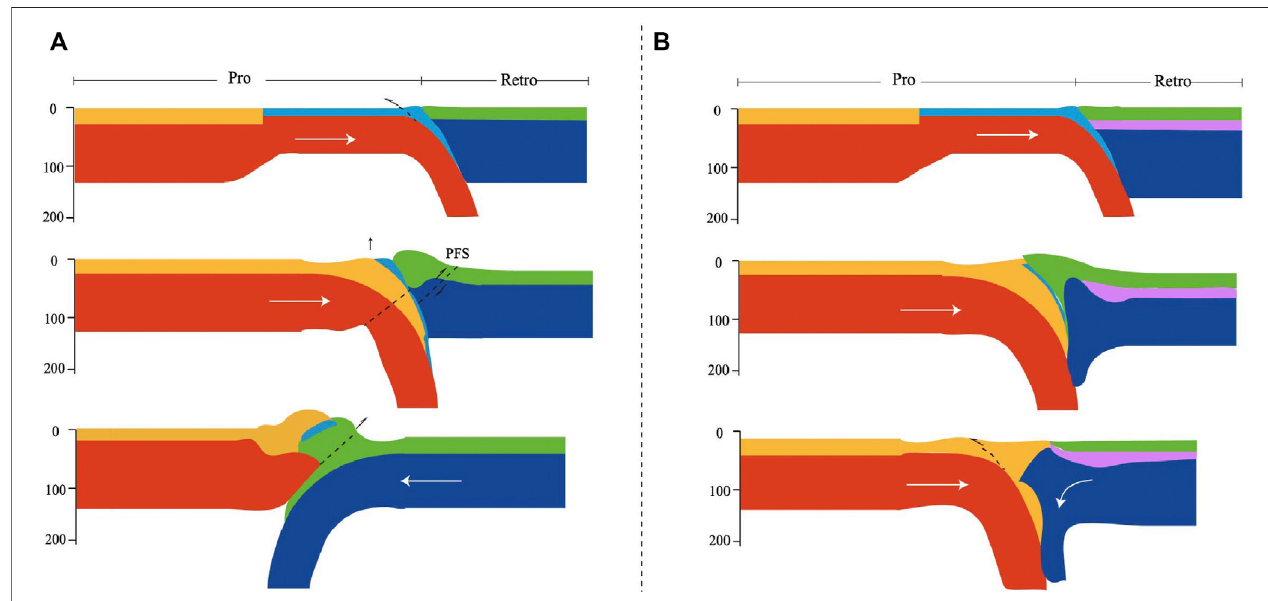
FIGURE 9 | Schematic diagram of the evolution of (A) polarity reversed mode in eastern Alps and (B) ablative mode in the Austroalpine of the western Alps. PFS is Periadriatic Fault System (Handy et al., 2015; Zhao et al., 2015).